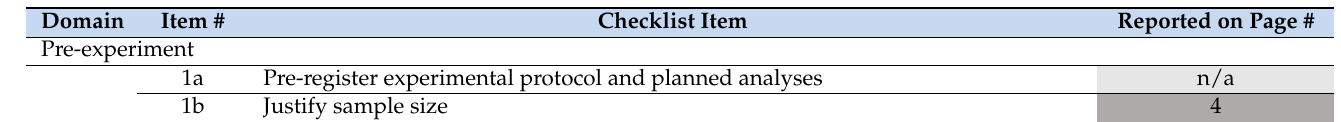
Table A1. Consensus on the reporting and experimental design of clinical and cognitive-behavioral neurofeedback studies (CRED-nf) best practices checklist